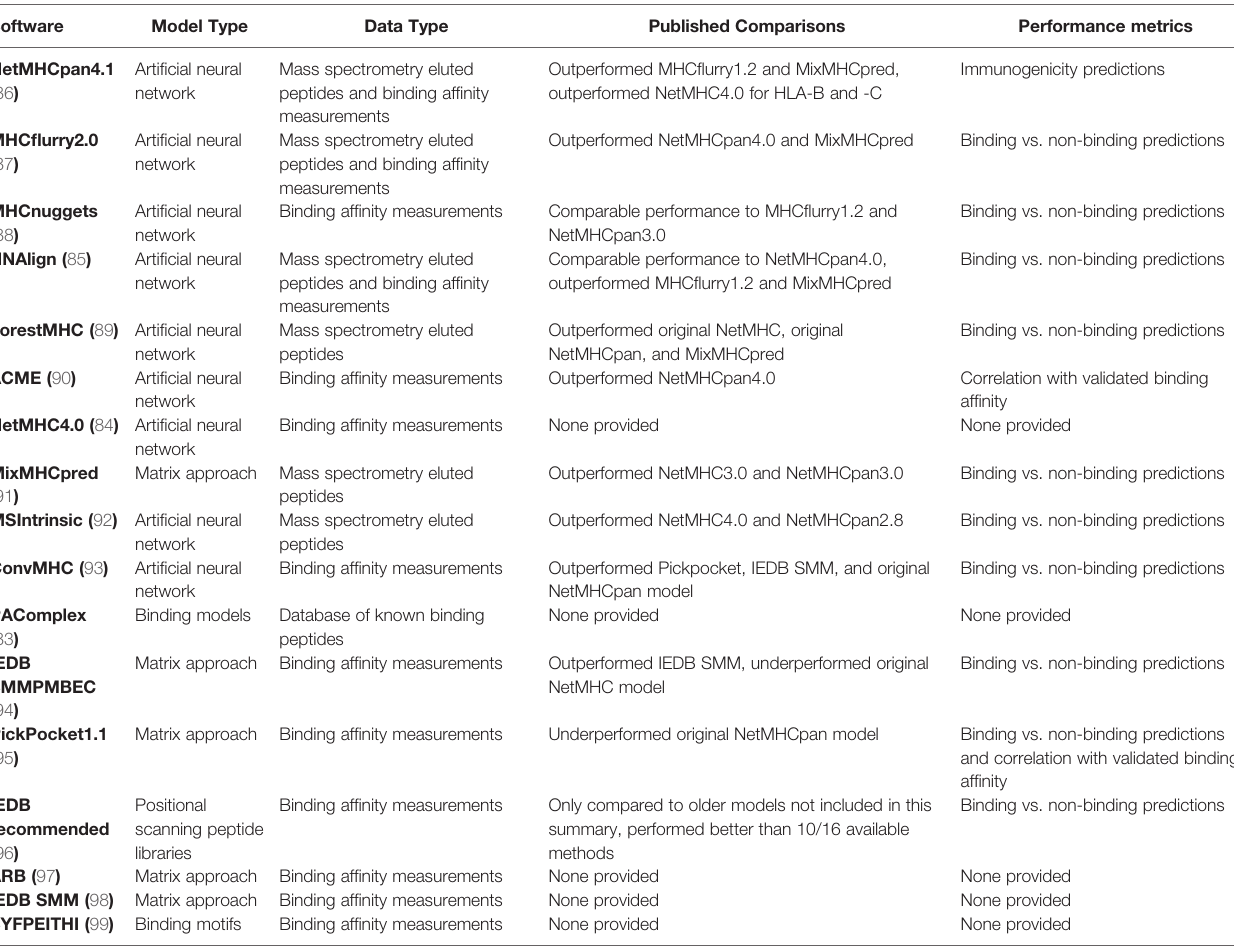
TABLE 3 | Comparison of available neoantigen: MHC class I binding prediction